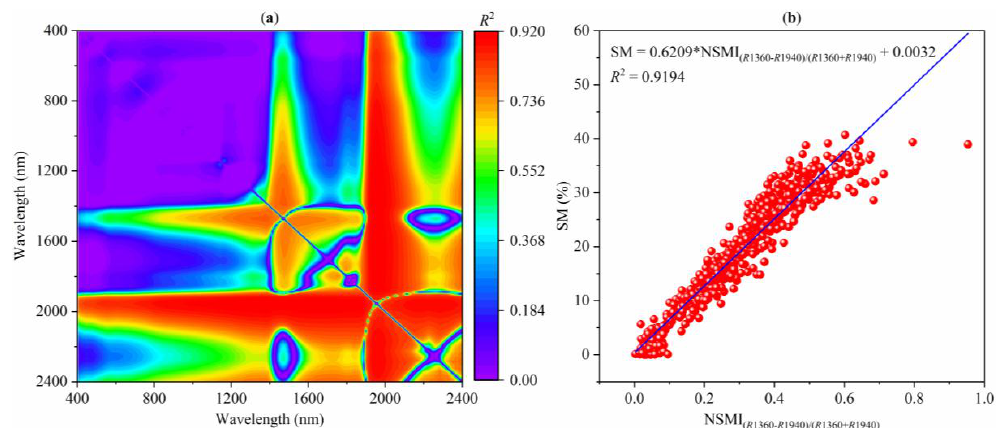
Figure 9. ( a ) 2-D correlogram of the coefficient of determination ( R 2 ) between SM and NSMI indices ( n = 640) and ( b ) the correlation between SM and the optimal NSMI index {( R 1360 − R 1940 )/( R 1360 + R 1940 )} at different SM levels ( n = 640). The blue line illustrated in the ( b ) is the regression line.